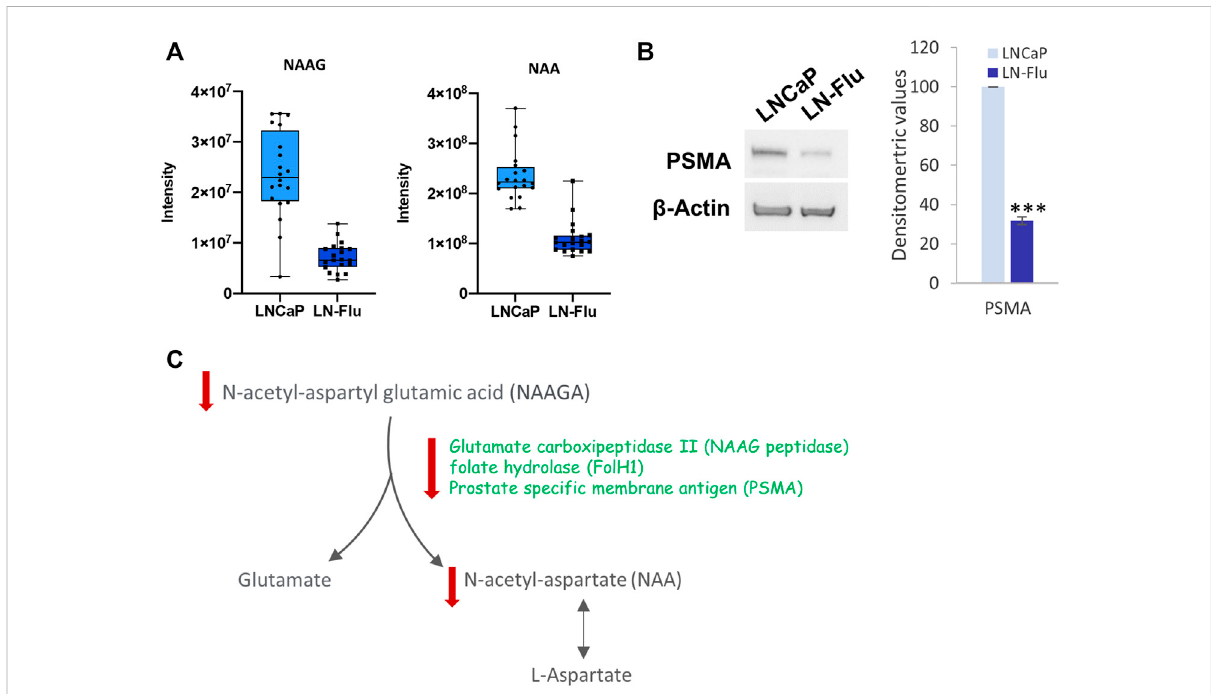
FIGURE 6 N-acetyl aspartate biosynthesis in prostate LN-Flu cells. (A) Box and whisker plot of metabolites involved in the pathway. (B) Levels Prostate speci fi c membrane antigen (PSMA) determined by Western blot. Densitometric analysis of the western blot bands from three independent experiments is shown on the right. Results are the mean ± S.D. of three independent experiments. *** p < 0.005 signi fi cant difference between LNCaP and LN-Flu cells by two-way ANOVA and Sidak ’ s multiple comparisons test. (C) N-acetyl-aspartate (NAA) biosynthesis showing the metabolites and enzymes we have found up (red arrow up) or down (red arrow down) in LNFlu cells compared to LNCaP